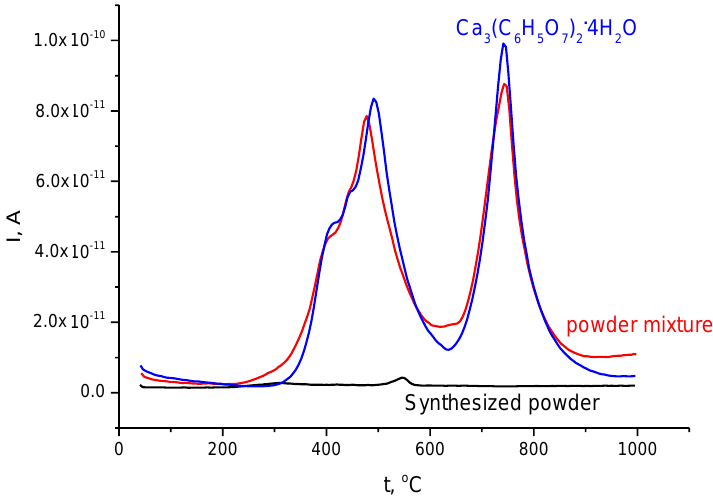
Figure 6. Mass spectra for evolving gases with m/Z = 44 for synthesized powder (in black), calcium citrate tetrahydrate Ca 3 (C 6 H 5 O 7 ) 2 ·4H 2 O (in blue), and their powder mixture (in red). The total mass loss of calcium citrate tetrahydrate Ca 3 (C 6 H 5 O 7 ) 2 ·4H 2 O according to thermal analysis data was determined as 67.6%. This mass loss is close to that calculated (70.5%) for the transformation of calcium citrate tetrahydrate Ca 3 (C 6 H 5 O 7 ) 2 ·4H 2 O into cal- cium oxide CaO, according to Reaction (8).